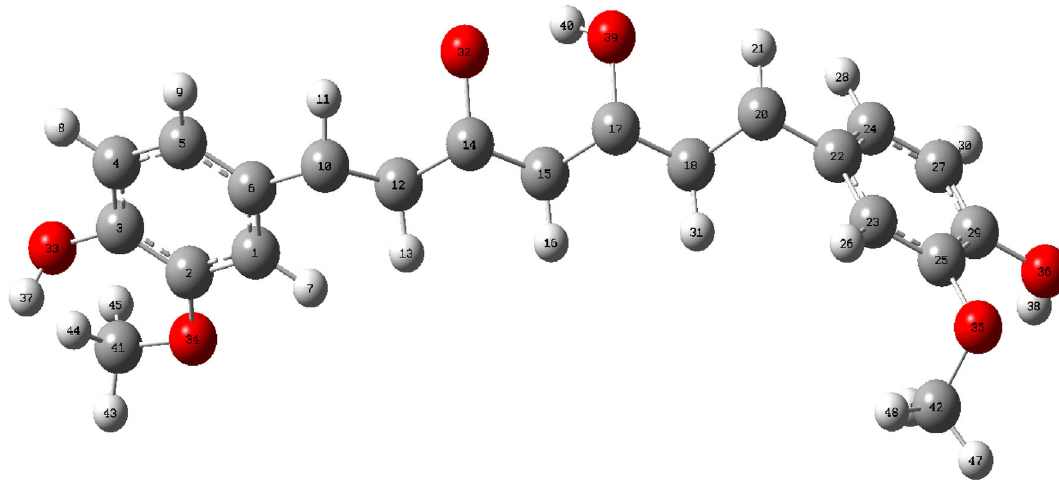
Fig. 1 Optimized monomer molecular structure of curcumin